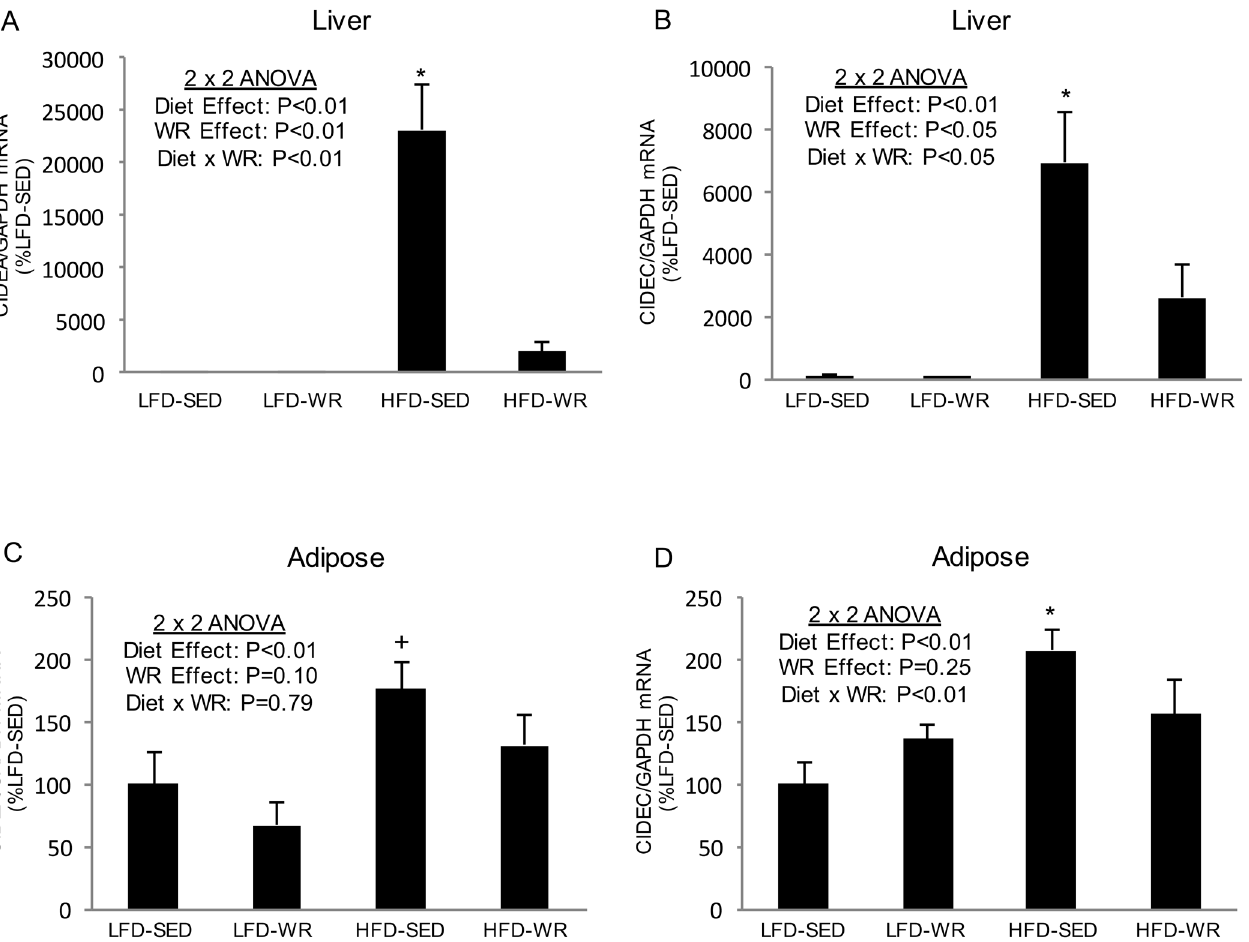
Fig 1. The effects of a high fat diet and voluntary wheel running on Cidea and Cidec mRNA expression in liver and adipose tissue. Cidea and Cidec gene expression for liver (Panels A and B) and epididymal white adipose tissue (Panels C and D) were normalized to GAPDH and expressed relative to LFD-SED values. * Denotes statistically significant difference from all other groups by Fisher ’ s LSD post-hoc test. + Denotes statistically significant difference from LFD-SED and LFD-WR groups by Fisher ’ s LSD post-hoc test. The number of mice per group is 4 – 5.